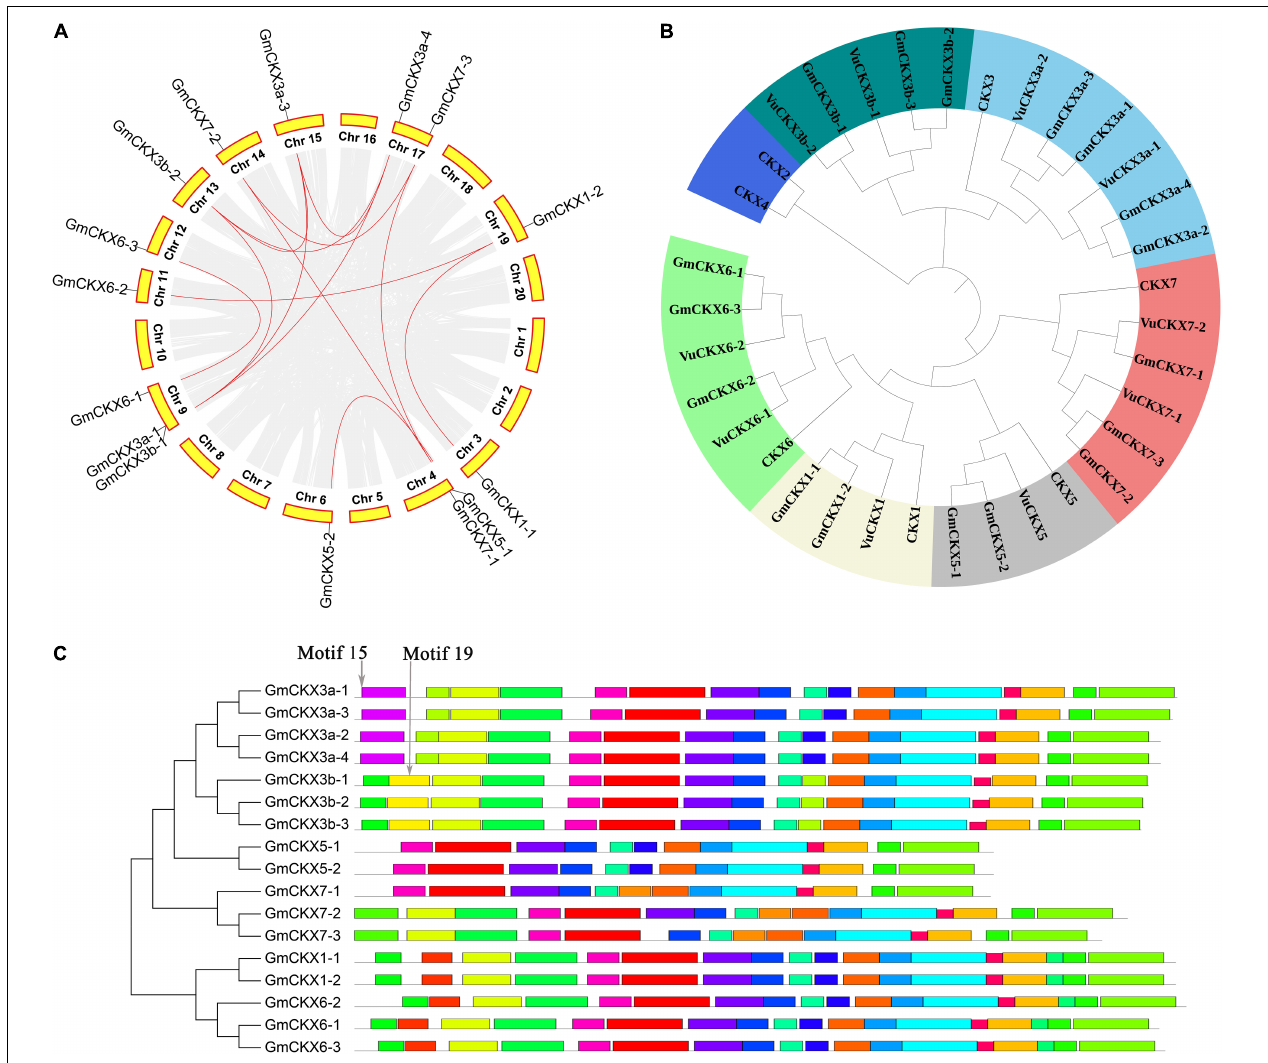
FIGURE 3 | Bioinformatics analysis of CKX gene family in soybean. (A) Collinearity analysis of CKX gene family in soybean. (B) Phylogenetics tree of CKX gene family in Arabidopsis , Glycine max , and Vigna unguiculata . (C) The conserved motifs of GmCKX gene family.